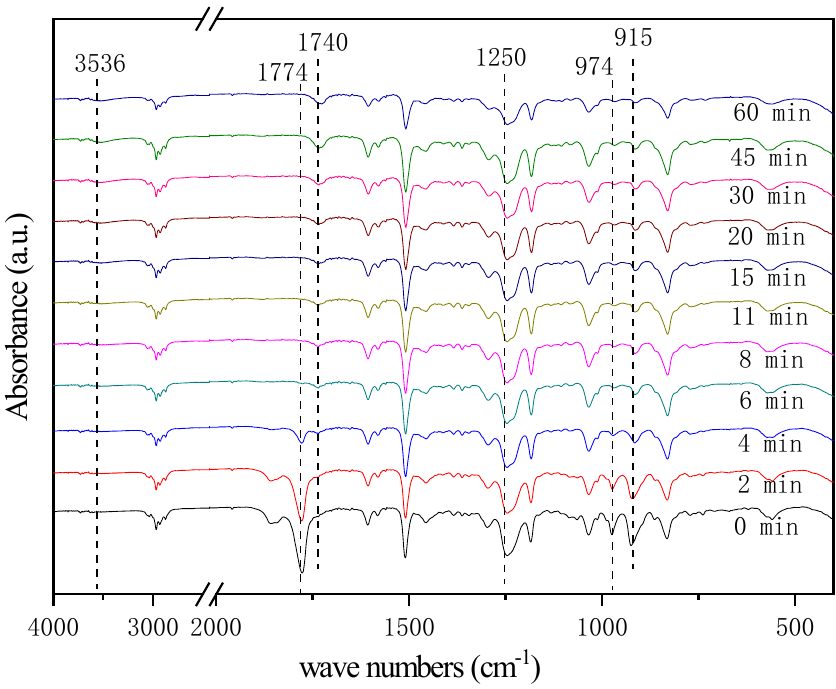
Figure 5. The FTIR spectrogram of the E51-MeTHPA curing system at different curing times (T = 199 °C, m = 41 wt%).